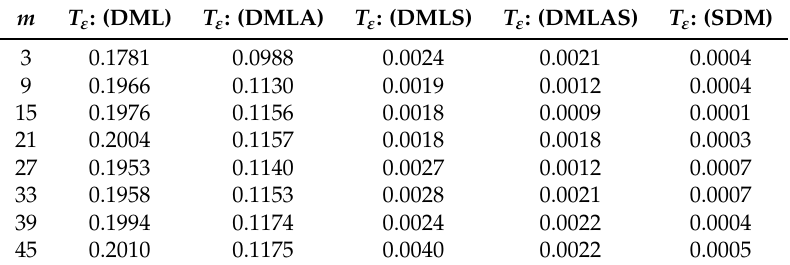
Table 3. Results for Case L with J = 510, ε = 10 − 2 .